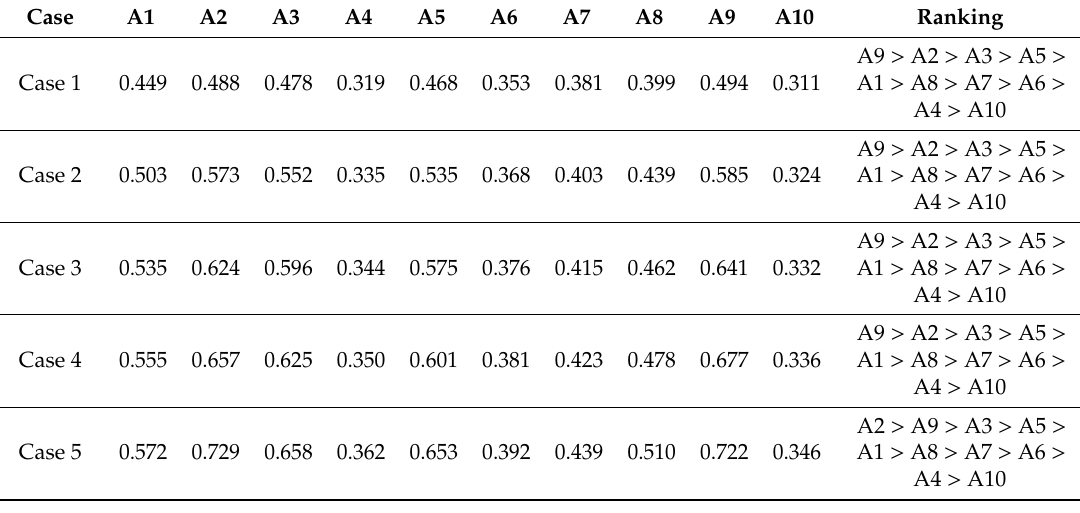
Table 20. Results of sensitivity